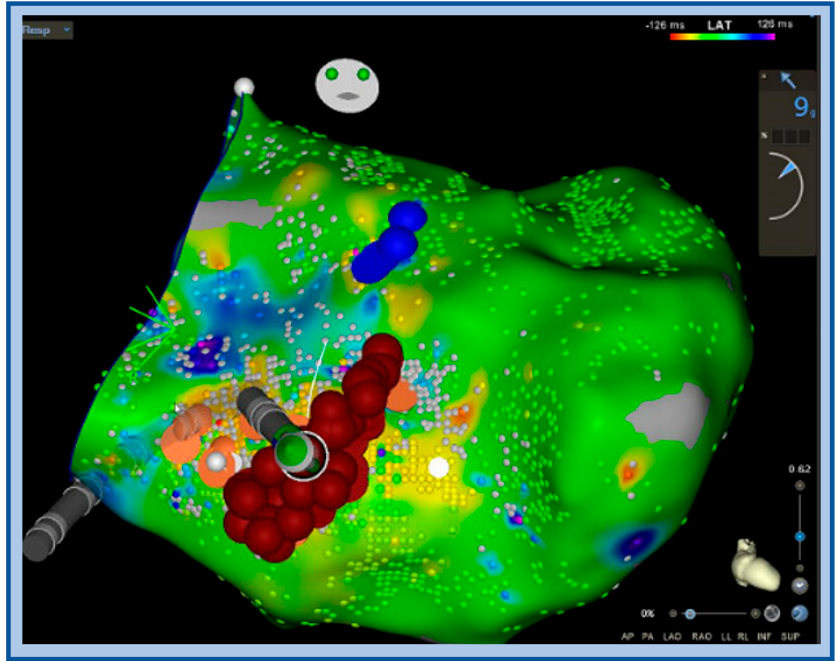
Figure 10. Activation map with ablation lesions transecting the left posterior fascicle (orange dots) blue dots denote the left anterior fascicle, ablation was performed to transect the LPF at this level, which also included very fractionated signals locally.